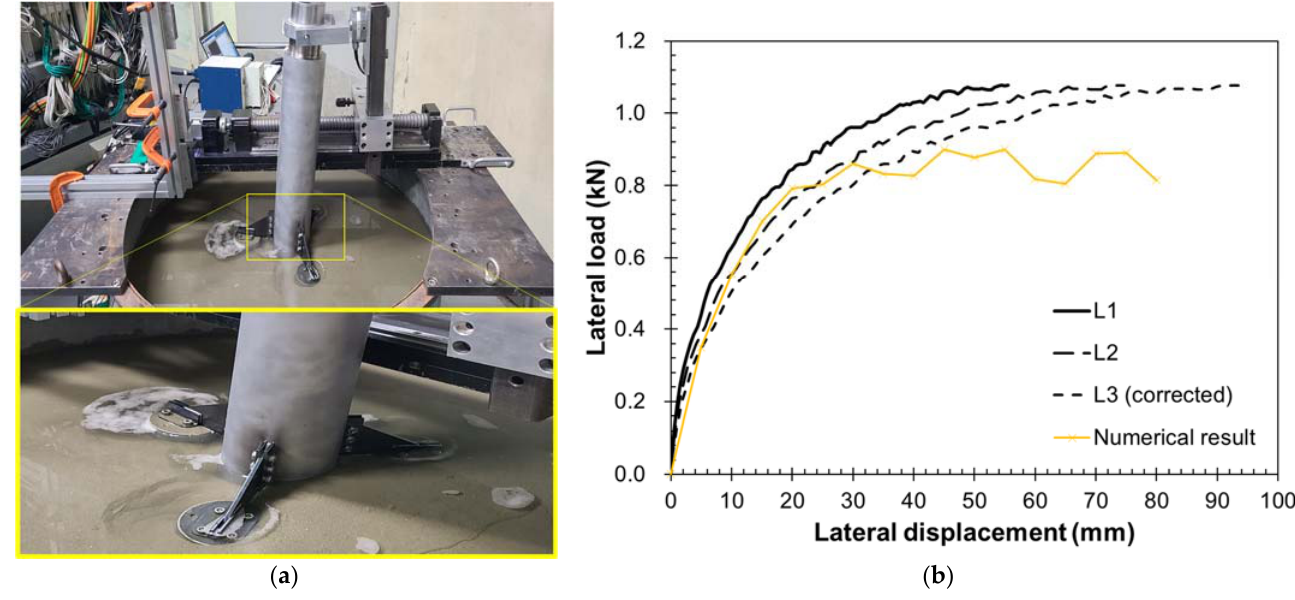
Figure 9. Physical and FE-based test comparison for hybrid monopile: ( a ) surface subsidence after loading of physical test; ( b ) load–displacement curves from physical and FE models.